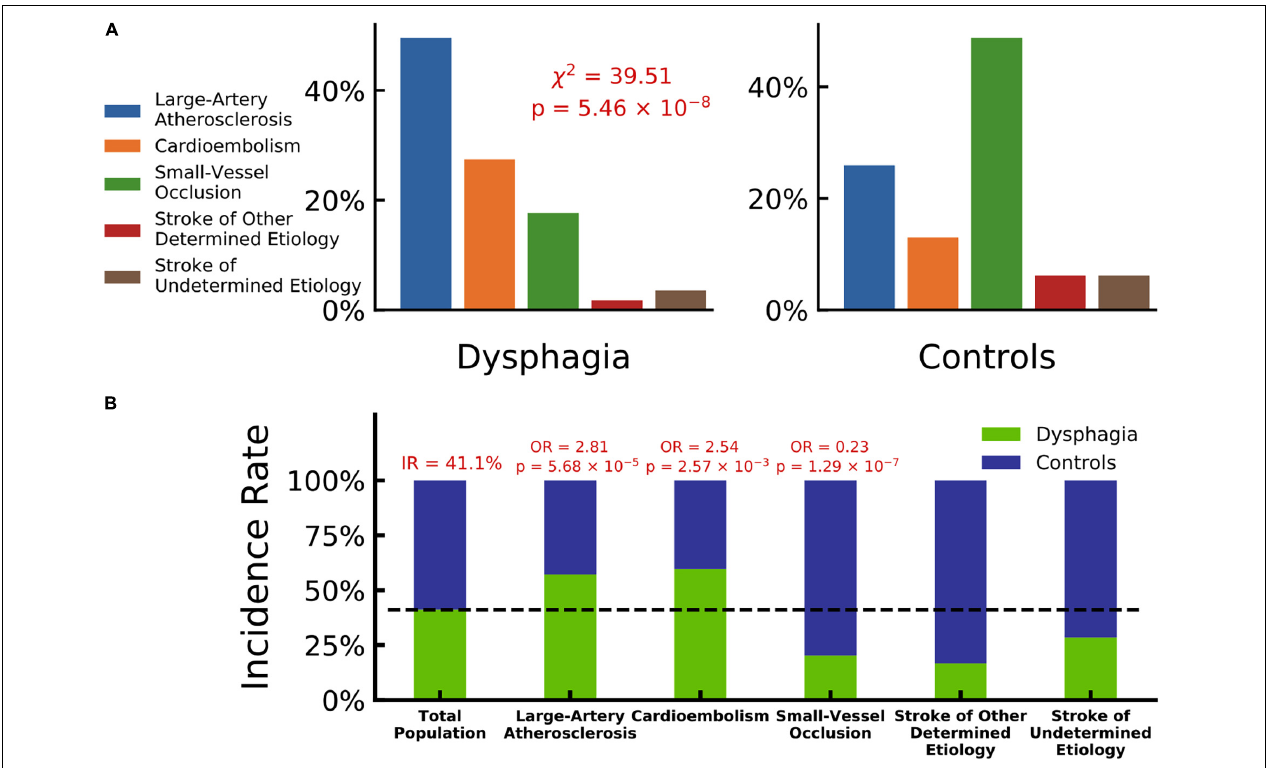
often (OR = 0.23, P < 0.01). Patients of other determined and UD did not show significant